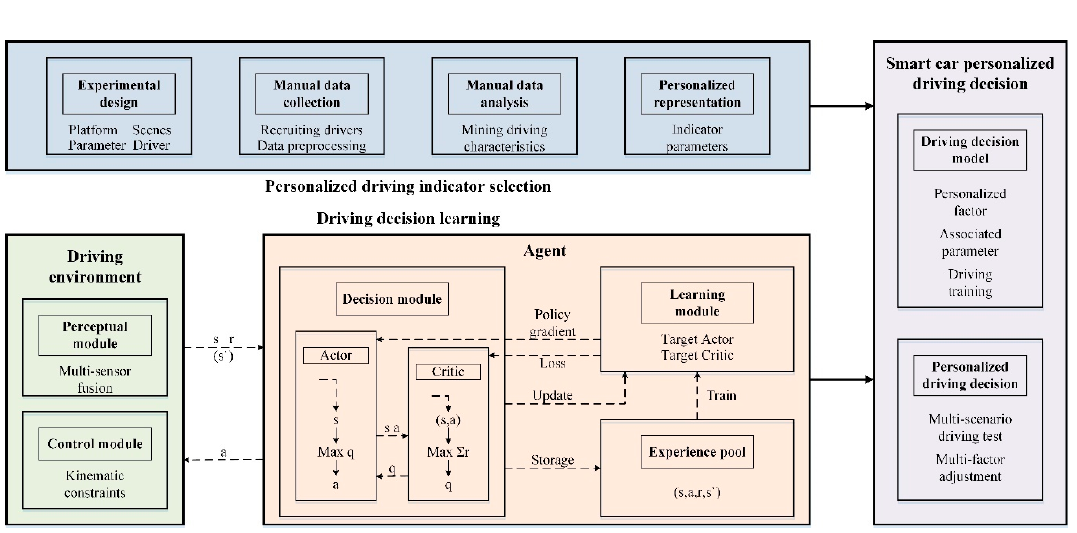
Figure 2. Structure of driving decision system.